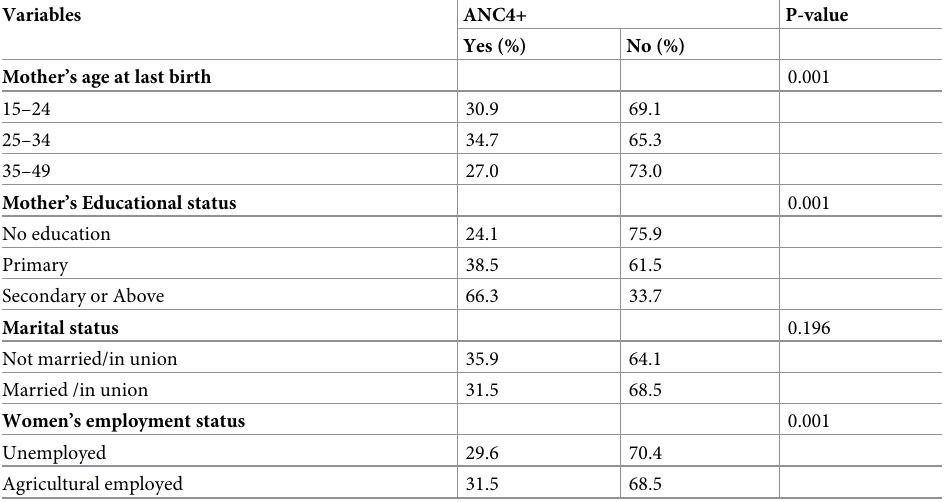
Table 1. Distribution of ANC4+ visits byselected independent variables among women who had a live birth in the last five years preceding the survey (N = 7590). Variables ANC4+